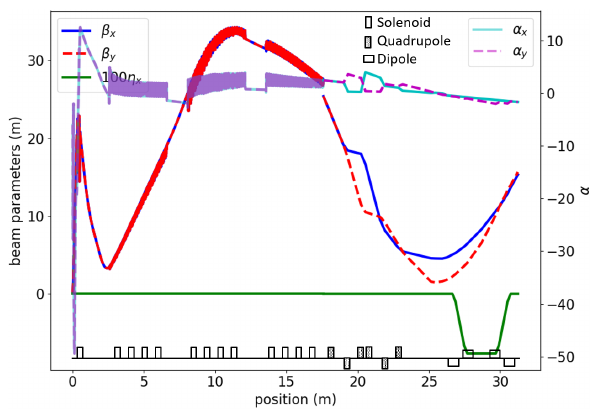
FIG. 3. The Twiss parameter β evolution is illustrated along the length of the linac. The BC terminates at z ∼ 31 . 5 m, the plasma is anticipated to be located at z ∼ 35